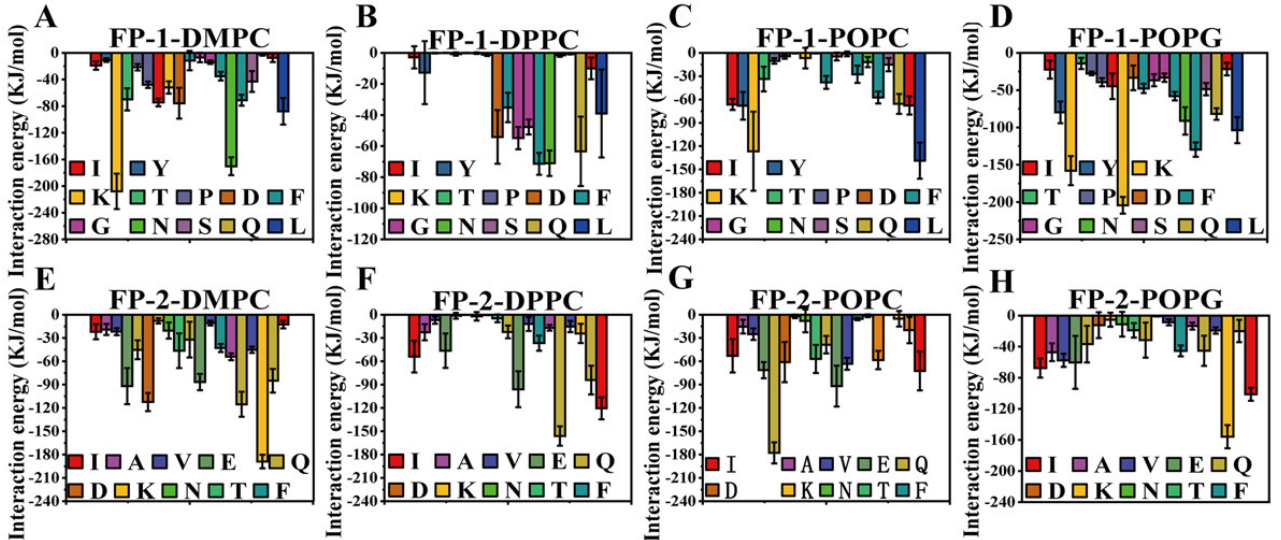
Figure 6. Analysis of the simulation process between the functional peptides and the lipid membrane at equilibrium was performed in the last 25 ns of the simulation (t = 475–500 ns). ( A – H ) The interaction-energy average values between each amino acid. Error bars denote standard deviation (s.d.).